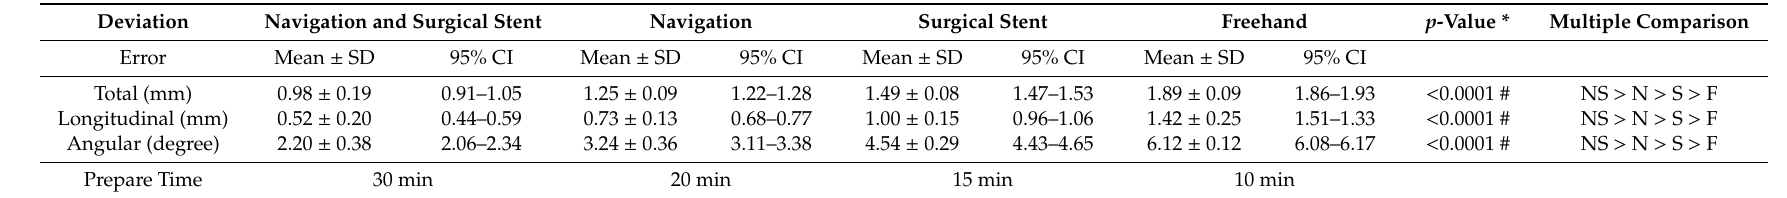
Table 1. The deviation of the total, longitudinal, and angular errors in the di ff erent surgical